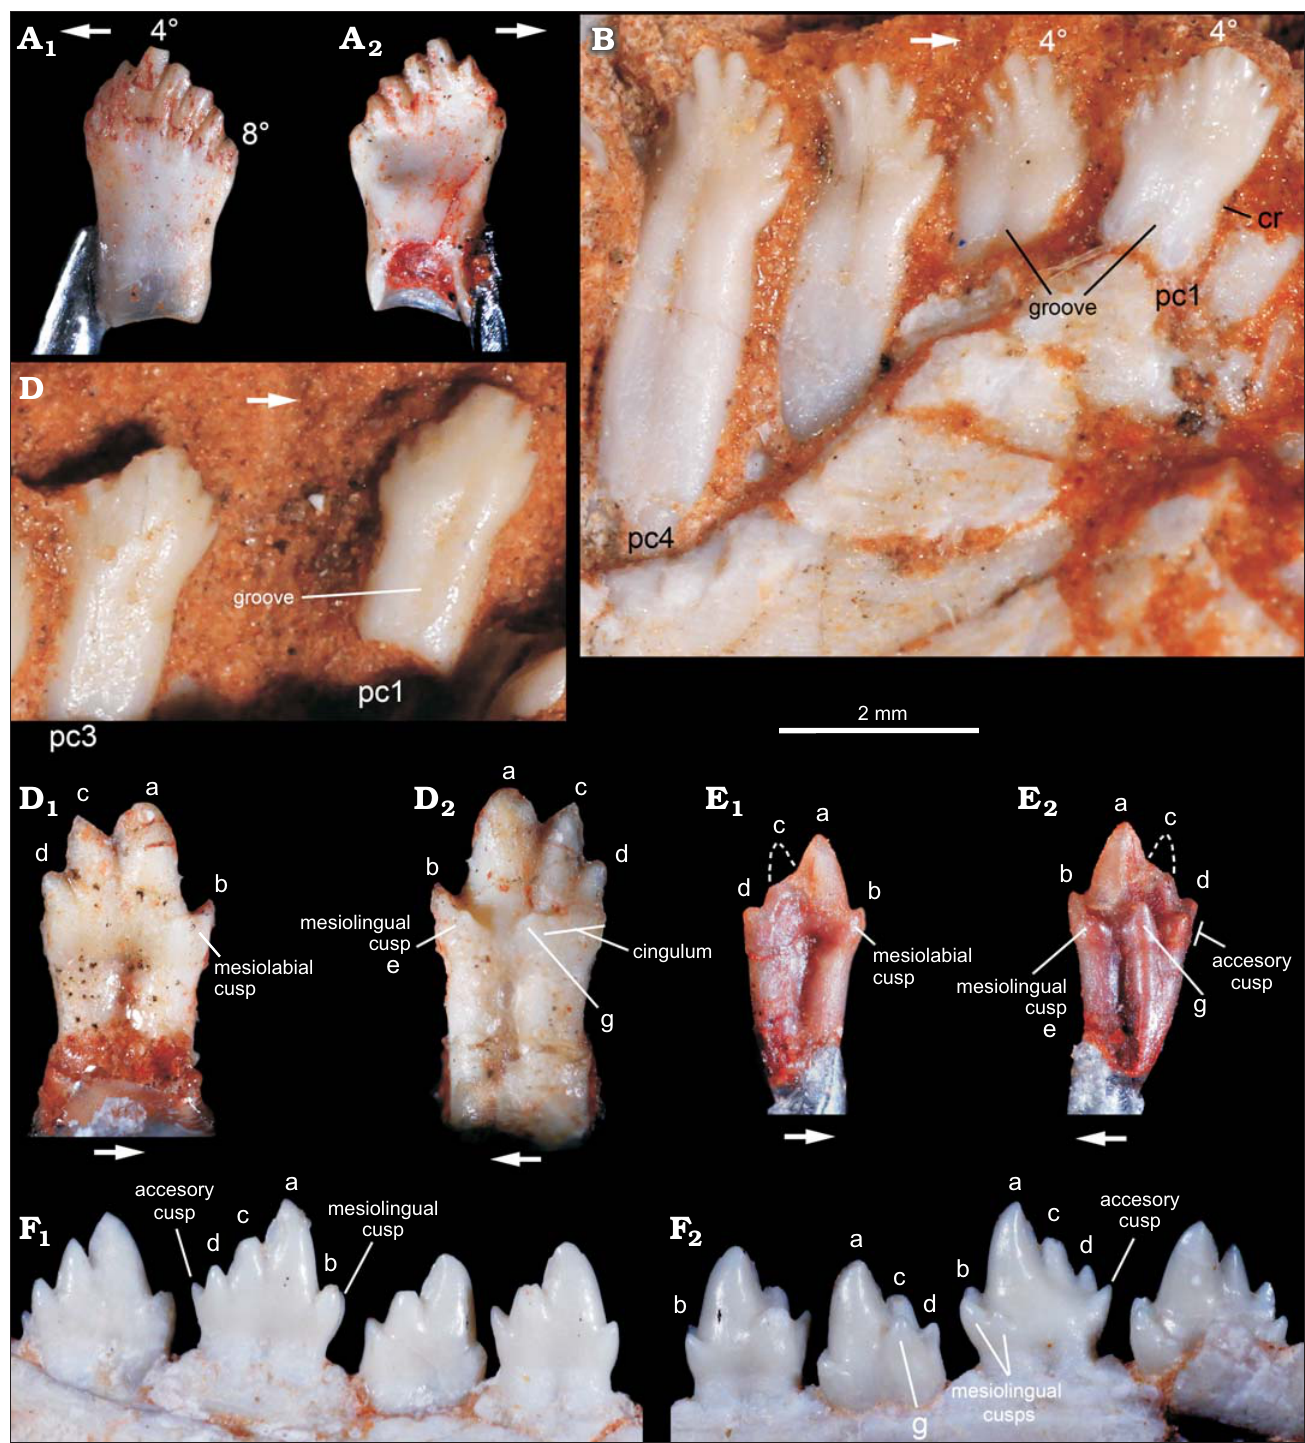
Fig. 8. A . Probainognathian cynodonts from Sacisaurus site, Late Triassic Caturrita Formation, Agudo, Rio grande do Sul, Brazil; isolated left lower postcanine tooth (MCN-PV 10204) originally interpreted as belonging to Riograndia , in labial (A 1 ) and lingual (A 2 ) views. B , C . Riograndia guaibensis Bonaparte, Ferigolo, and Ribeiro, 2001 from the Riograndia Assemblage Zone, Linha São Luiz site, Late Triassic Caturrita Formation, Faxinal do Soturno, Rio grande do Sul, Brazil; anterior postcanines of UFRGS-PV-833-T in lingual view ( B ) and UFRGS-PV-1319-T in labial view ( C ). D , E . Riograndia guai- bensis from Sacisaurus site, Late Triassic Caturrita Formation, Agudo, Rio grande do Sul, Brazil, originally referred to Brasilitherium riograndensis ; iso- lated right lower postcanines of MCN-PV 10102 ( D ) and MCN-PV 10103 ( E ), in labial (D 1 , E 1 ) and lingual (D 2 , E 2 ) views. F . Brasilodon quadrangularis Bonaparte, Martinelli, Schultz, and Rubert, 2003 from the Riograndia Assemblage Zone, Late Triassic Caturrita Formation, Faxinal do Soturno, Rio grande do Sul, Brazil, UFRGS-PV-603-T (inverted), detail of middle and posterior left lower postcanines, in labial (F 1 ) and lingual (F 2 ) views. Abbreviations: 4 o , fourth cusp; 8 o , eighth cusp; a–d, names of lower cusps; (e), cusp e; g, lower cusp g; cr, constriction; pc1, pc4, postcanine tooth 1 and